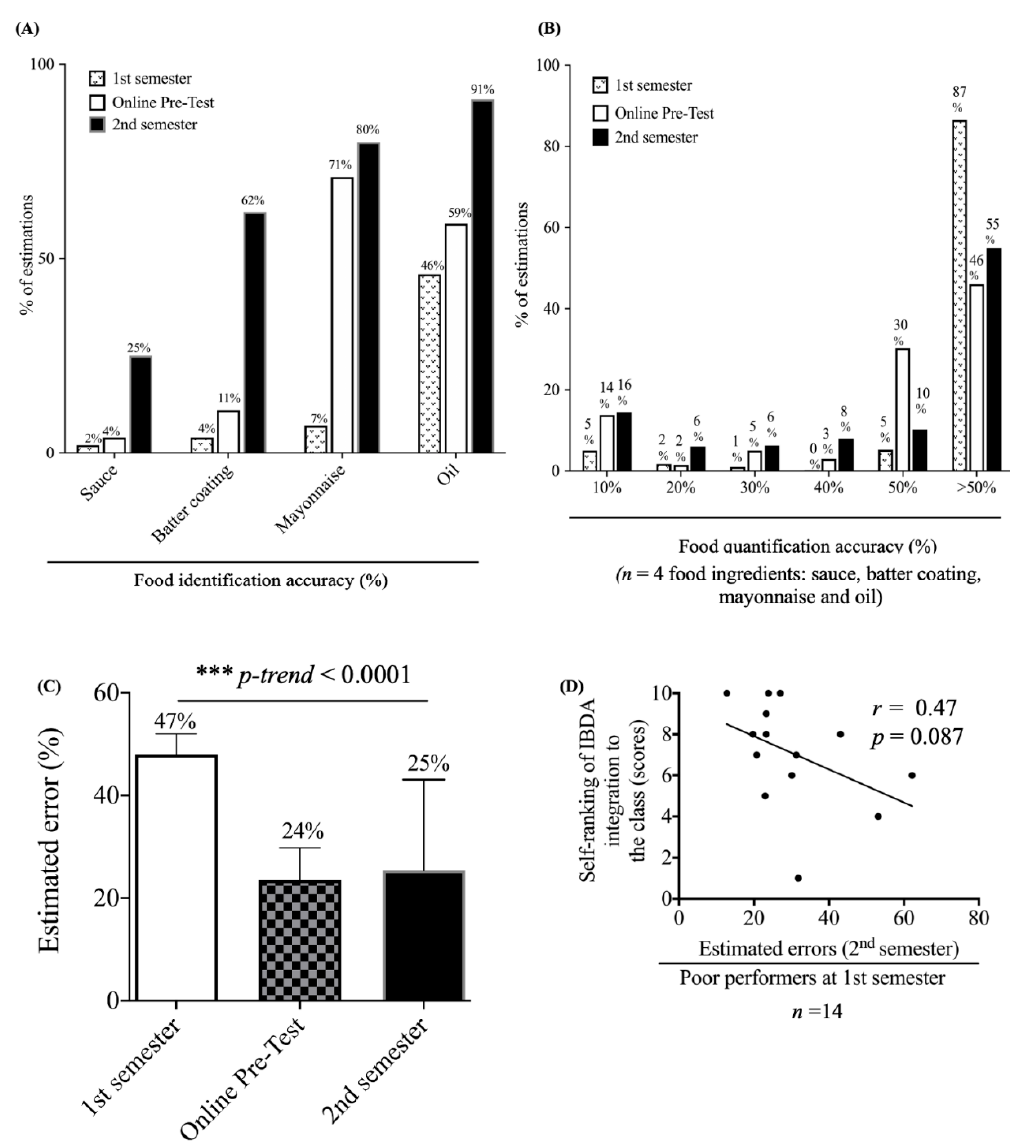
Figure 3. Effects of repeated image-based dietary assessment (IBDA) training on the identification ( A ) and quantification ( B ) of condiments, cooking oils, and batter coatings, and poor performers (defined as ≥ 3 answers within >50% of the ground truth kcal on the first semester exam) ( n = 14); linear trend test using the median value of each semester data; *** p -trend < 0.0001 ( C ). Spearman correlation analysis of self-ranking scores of usefulness of IBDA integration into the course and the median estimated error among poor performers ( n = 14) ( D